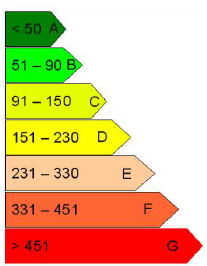
Figure 1. French Energy